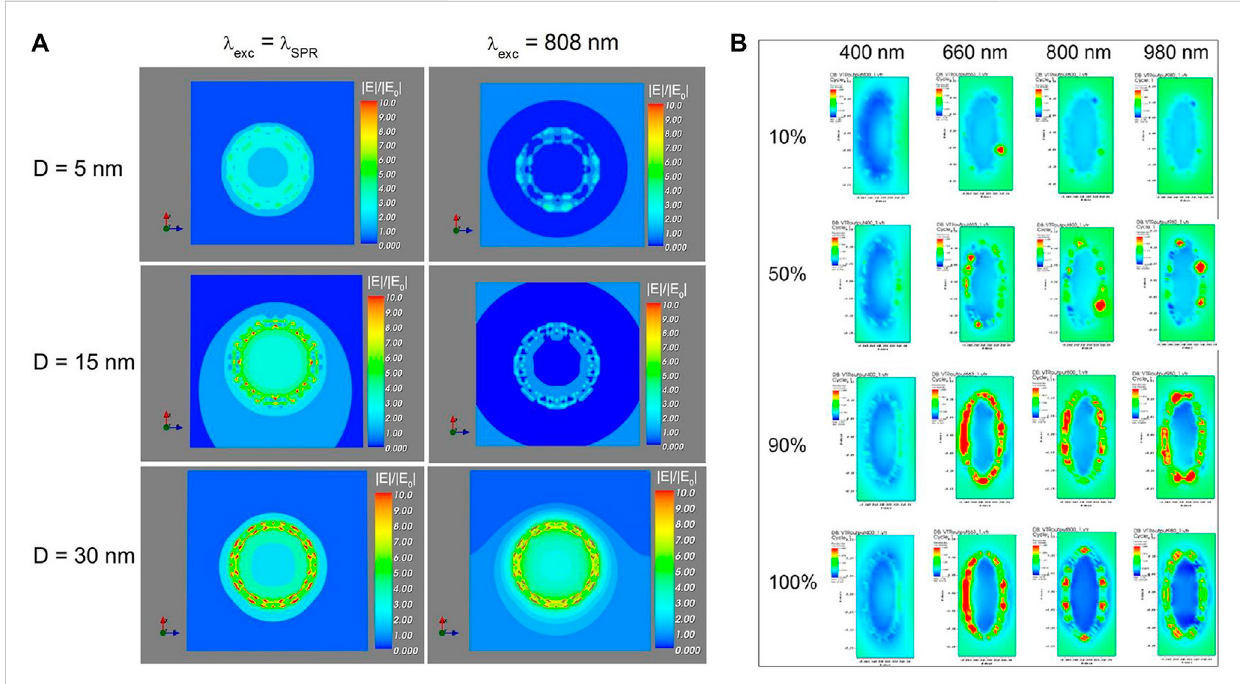
FIGURE 2 (A) Simulation of the electric fi eld strength (|E|/|E0|) of Ln-UCNPs@mSiO2-Au NPs (15 nm – D – 5 nm geometry) under irradiation at λ exc = λ SPR and λ exc= 800 nm,with differentsilicaspacerswith thicknessD of5,15, and30 nm |E|/|E0| istheenhancementfactor. The electric fi eld isampli fi edas |E| > | E0|. [Reprinted with permission from Ref. (Lv et al., 2018a) Copyright 2018: Lv et al. (2018a)]. (B) DDSCAT simulation results. Extinction spectra of the corresponding electronic strength images of SPS@Au. [Reprinted with permission from Ref. (Lin et al., 2020) Copyright 2020: American Chemical